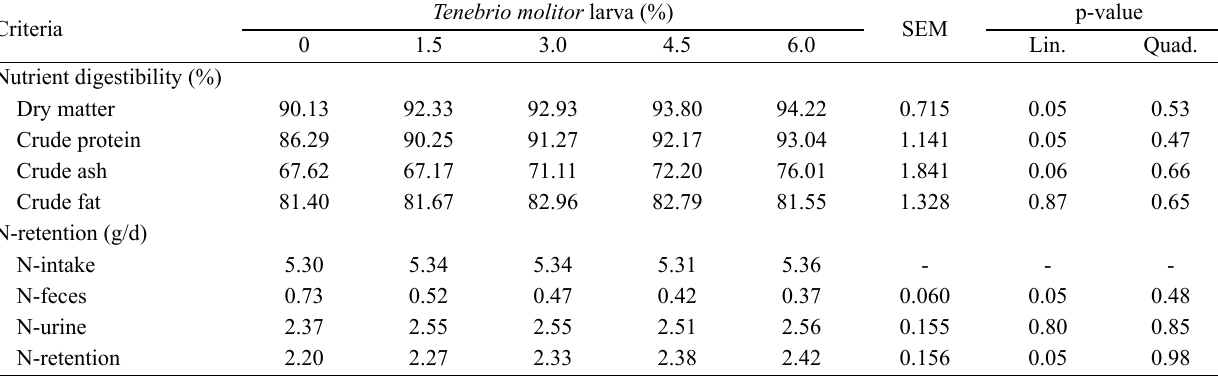
Table 5. Effect of dried mealworm larvae supplementation on nutrient digestibility in weaning pigs 1,2